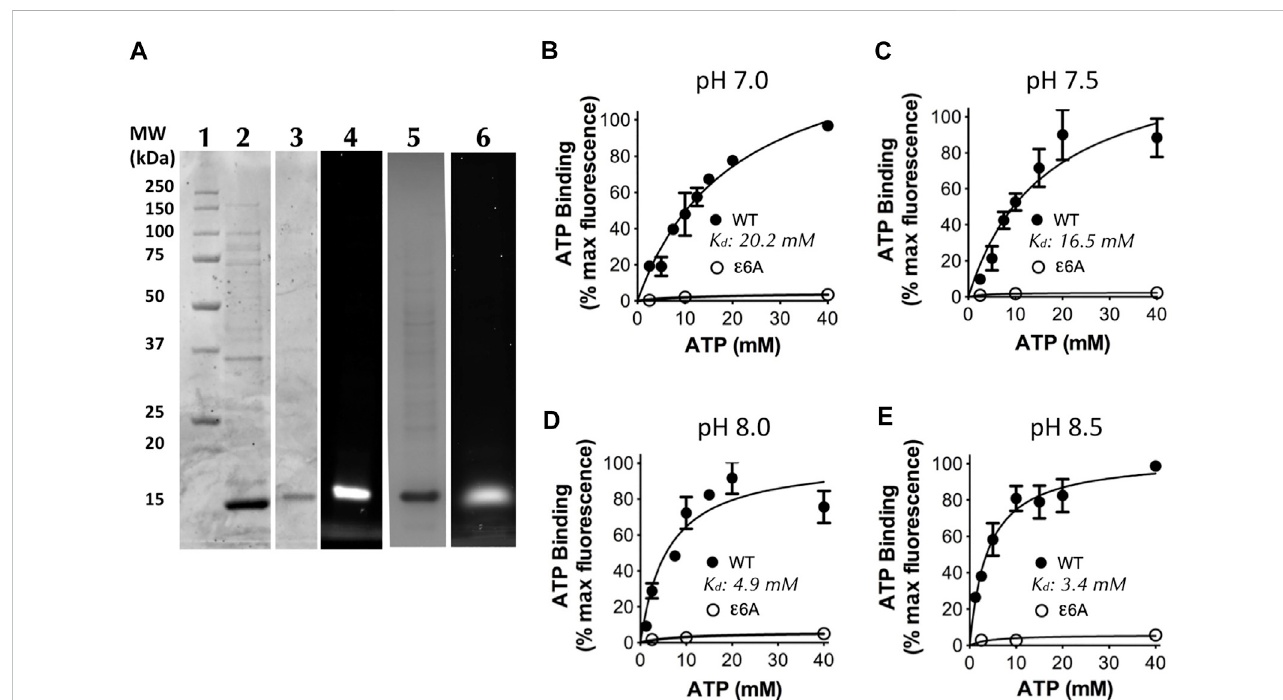
FIGURE 4 ATP binding by the C. thermarum ε subunit is regulated by pH. (A) SDS analysis of the ε subunit. Lane 1, Precision Plus protein standards (Biorad); Lane 2, as-puri fi ed C. thermarum ε subunit, Lanes 3 and 4, Cy3-labelled C. thermarum ε subunit visualized under either white light (Lane 3), or under a fl uorescence emission fi lter at 590 nm (Lane 4). Lanes 5 and 6, Cy3-labelled C. thermarum ε 6A mutant ε subunit visualized under either white light (Lane 5), or under a fl uorescenceemission fi lterat590 nm(Lane6). (B – E) :ATPbindingcurvesusing.4 μ MCy3-labelled C.thermarum ε subunitwithhyperbolic1-site fi tting in the presence of equimolar Mg 2+ at physiological relevant bulk-phase cell cytoplasmic pH values: (B) pH 7.0; (C) pH 7.5; (D) pH 8.0; or (E) pH 8.5. All results shown are the product of 3 experimental